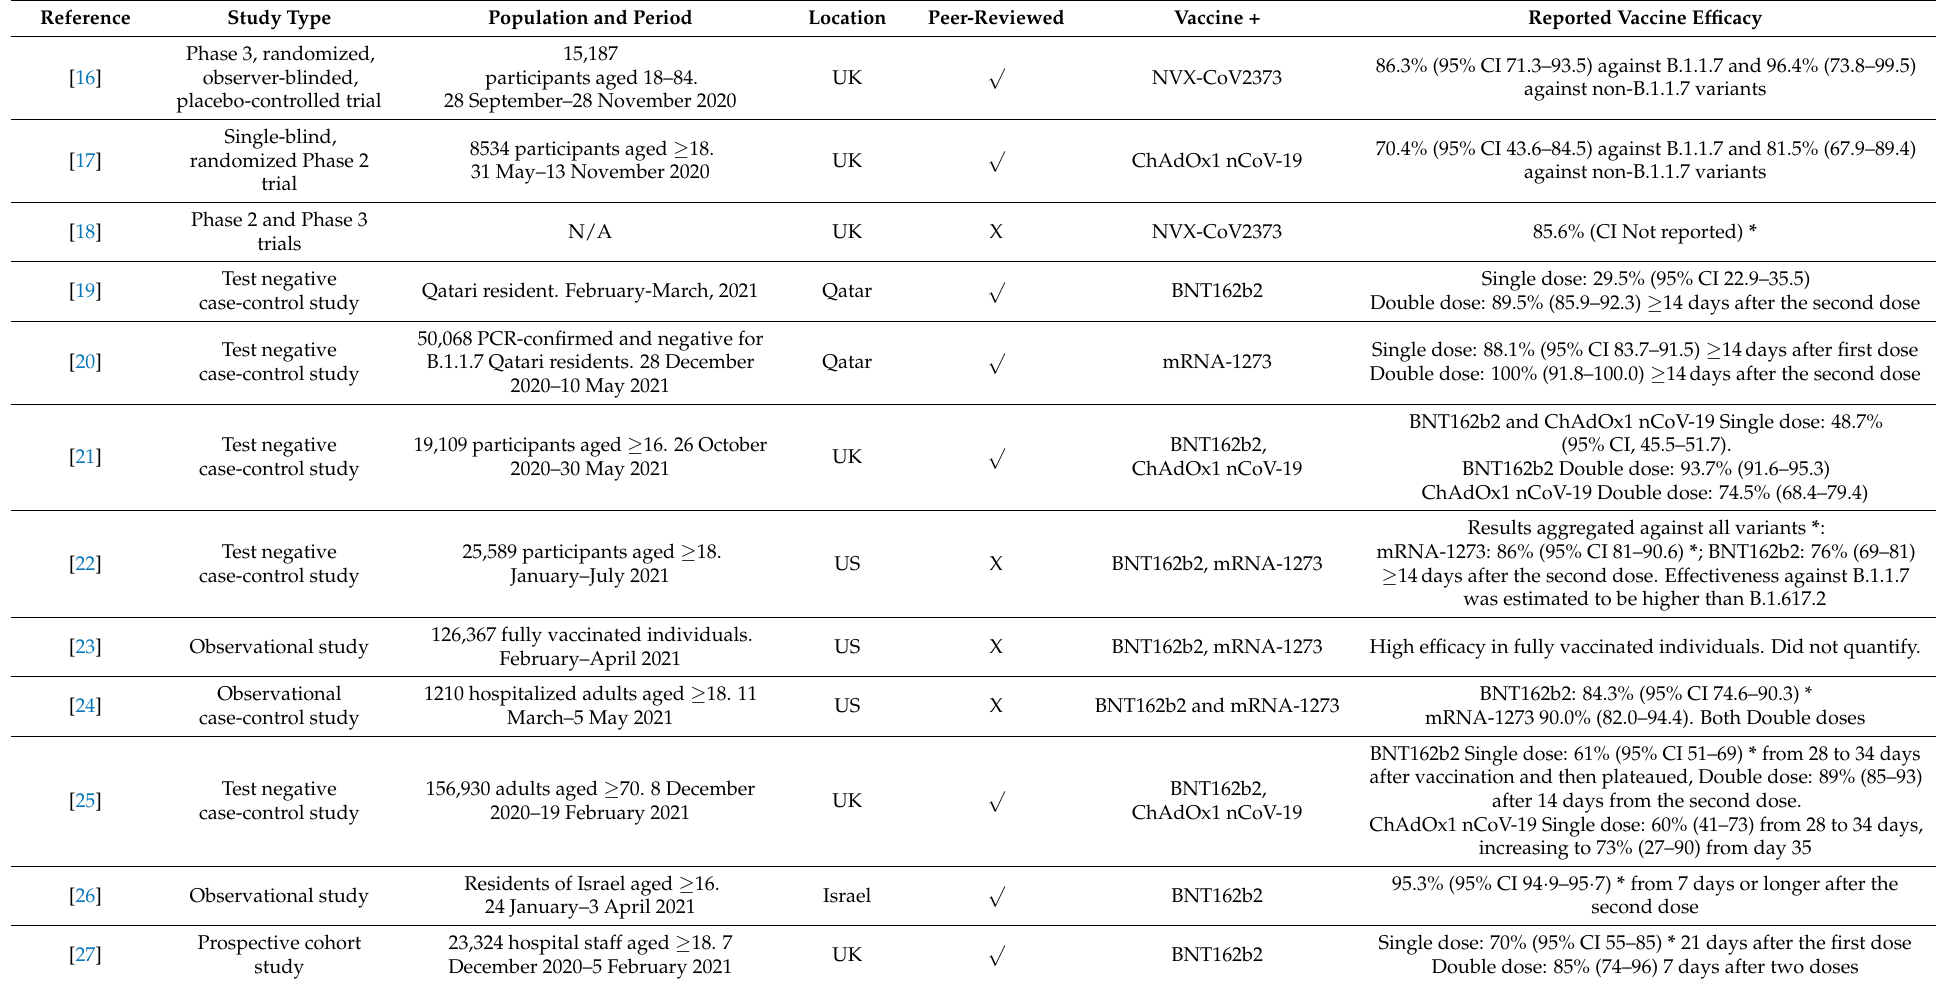
Table 2. Vaccine Effectiveness Against Alpha (B.1.1.7)